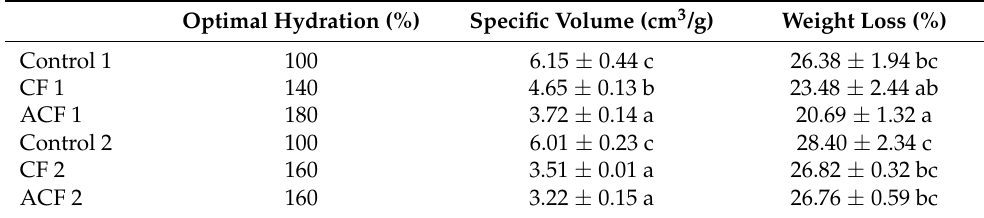
Table 3. Specific volume and weight loss of gluten-free breads with or without CF. Optimal Hydration